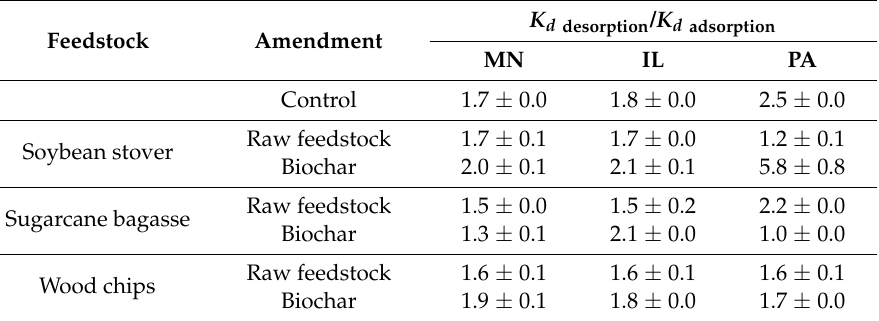
Table 3. Alachlor desorption properties on control and amended soils expressed as a ratio of the K d of desorption to the K d of